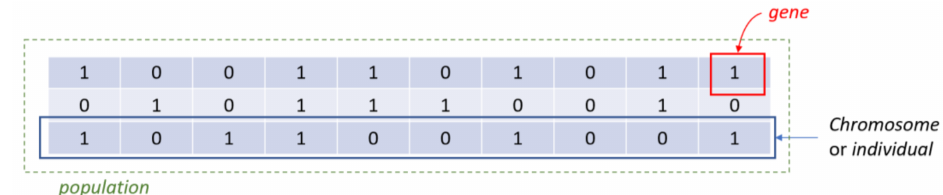
Figure 3. Definition of genes, chromosomes and